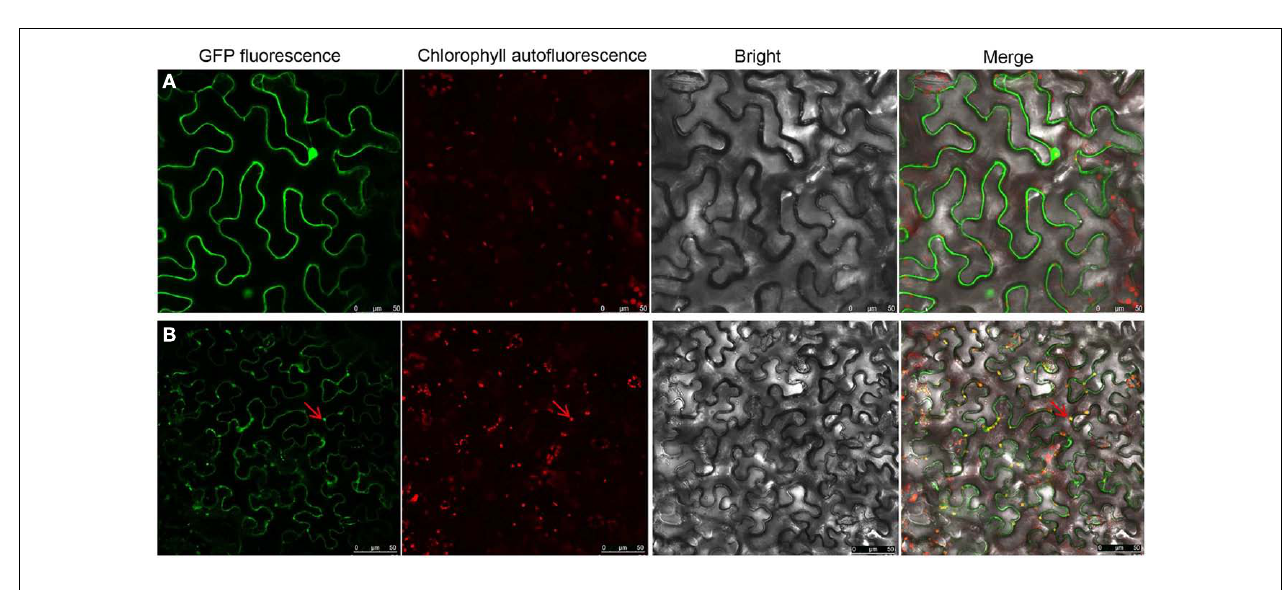
Fluorescence emissions were collected simultaneously, with a one photon multiplier-tube bandwidth set at 500–530 and 660–700nm, respectively. Arrows indicate the sphere-like compartments formed by NSvc4-eGFP fusion